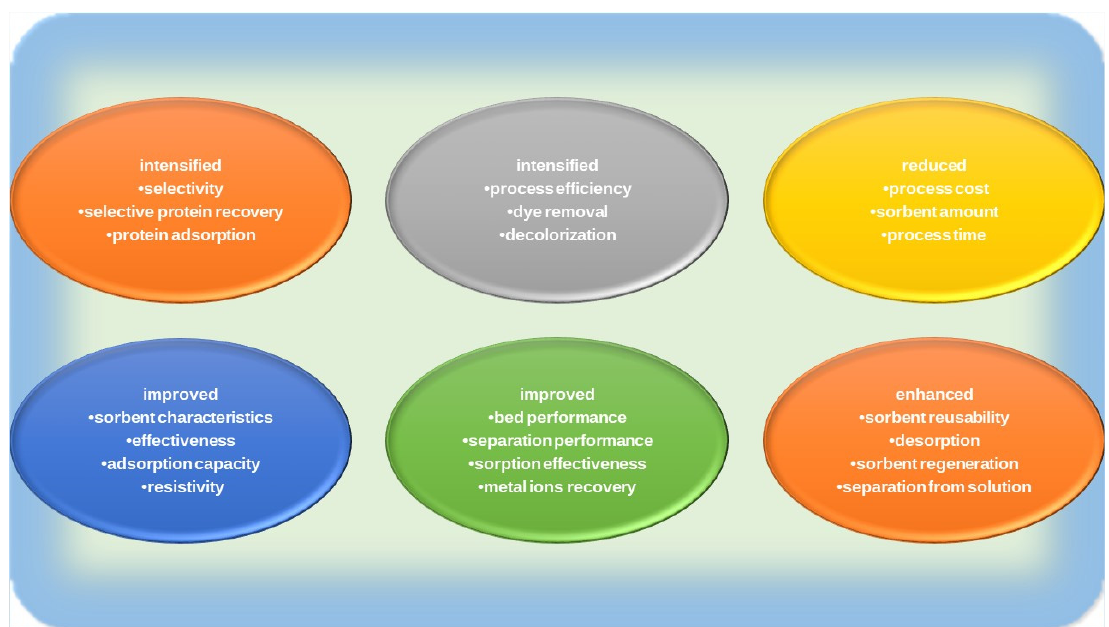
Figure 3. Major process intensification results in adsorption processes: decolorization of dyes; removal of aromatic hydrocarbons from wastewaters; and recovery of proteins, heavy metals and rare earth elements from aqueous media.